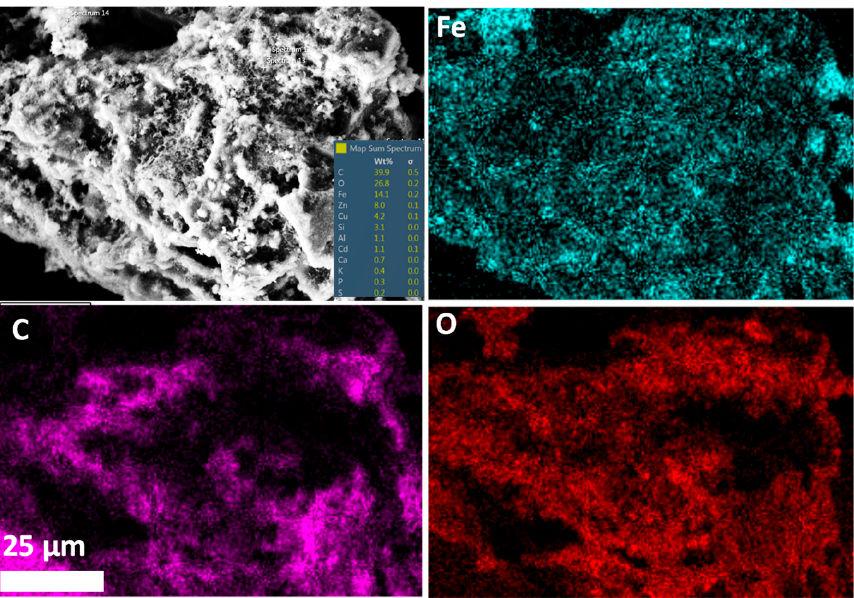
Figure 3. EDS mapping of BC-nZVI depicted that C, O, and Fe were the most plentiful components on the surface of biochar. The presence of distributed Fe confirmed a proper nZVI modification of biochar.